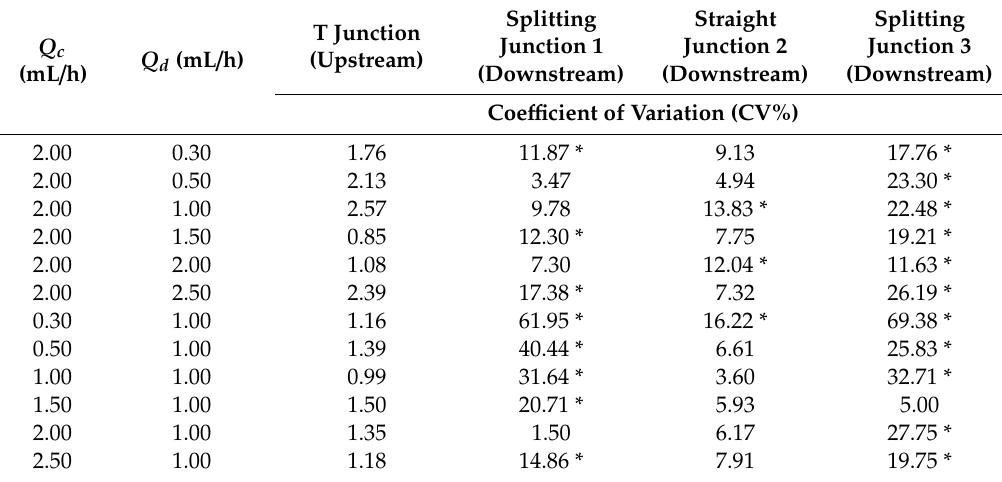
Table 2. Coe ffi cient of variation (CV%) of e ff ective droplet diameters in asymmetrical multifurcated channels at di ff erent flow